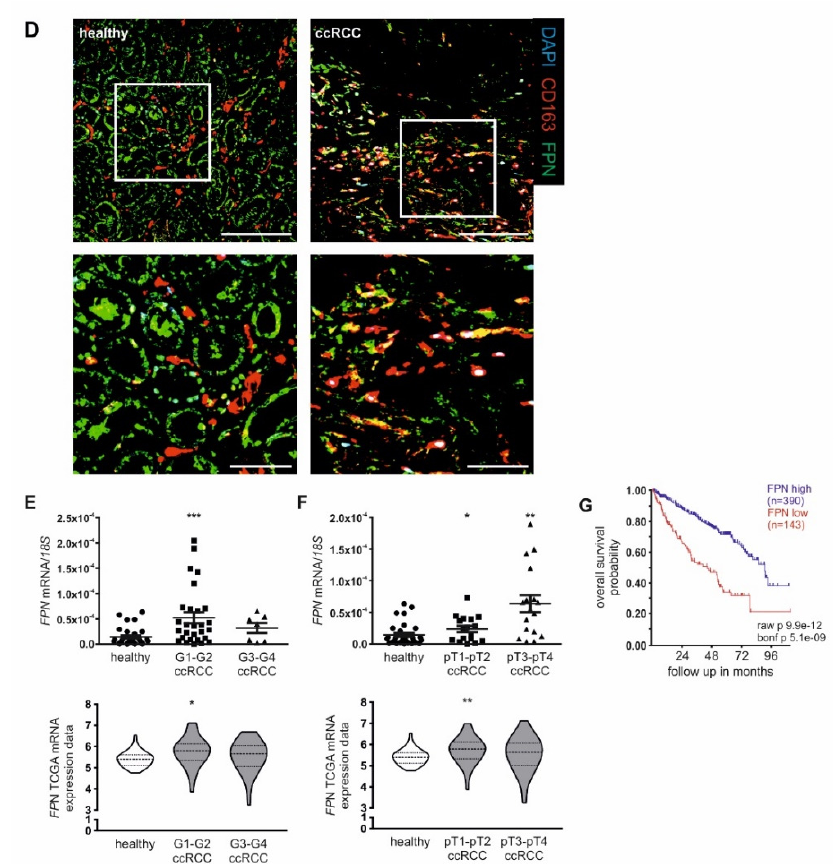
Figure 6. Tumor-associated M Φ express enhanced FPN protein. ( A ) FACS panel how to gate CD45 + immune cells and CD326 + epithelial / tumor cells. Immune cells were further gated for CD33 + / HLA-DR + cells of which CD64 + and MerTK + M Φ were sub-selected. Cells were subsequently analyzed for their FPN protein expression, displayed as MFI (mean fluorescence intensity). ( B ) FPN protein expression as MFI of CD45 - / CD326 - stroma cells ( n = 26). ( C ) FPN protein expression as MFI of M Φ in tumor tissue compared to adjacent healthy tissue ( n = 26). ( D ) Representative pictures for the M Φ marker CD163 and FPN protein expression in tumor tissue compared to healthy adjacent tissue applying confocal laser scanning miscroscopy. DAPI was used as nuclear stain. Scale bar: 200 µ m. FPN mRNA expression normalized to 18S expression correlated to ( E ) low (G1–G2) and high (G3–G4) tumor grade and ( F ) low (pT1–pT2) and high (pT3–pT4) tumor pT-stage in our patient cohort (upper panels; n = 48) compared to the TCGA data base, applying the ccRCC-KIRC data set (lower panels; n = 70). (G) Kaplan-Meier curve of high or low FPN expression from the R2 bioinformatics platform using the ccRCC-KIRC data set. Graphs are displayed as means ± SEM with * p < 0.05, ** p < 0.01, *** p < 0.001.